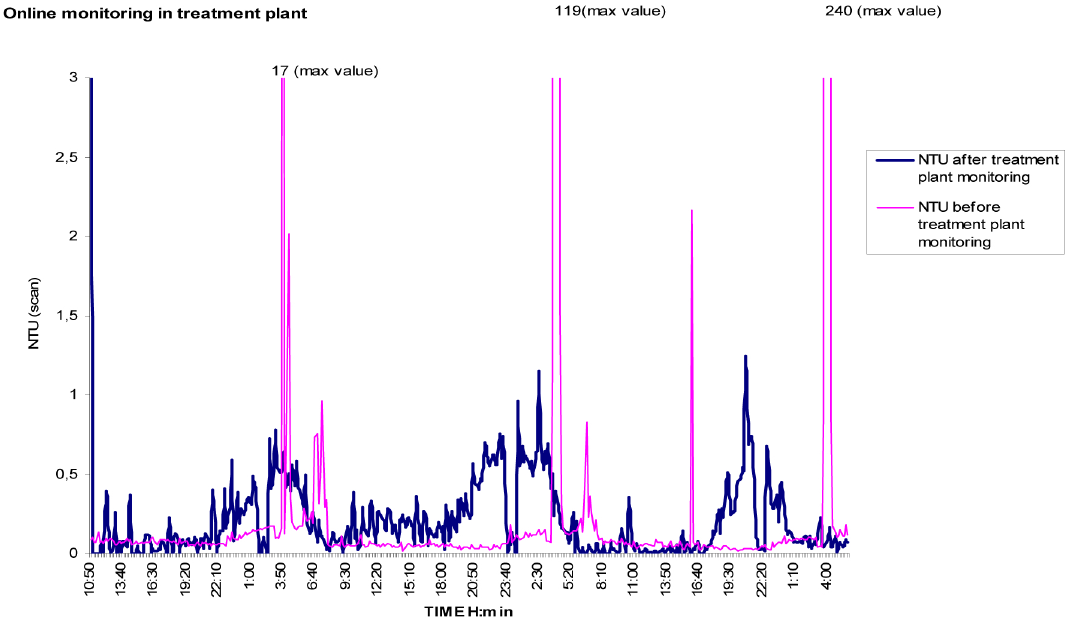
Figure 2. The online measurements of turbidity in the outlet of the WTP of the distribution network before and after the repair of the rapid sand filters. Values on the top of figure show the peaks of turbidity. Modified from Neilands et al. (2009).